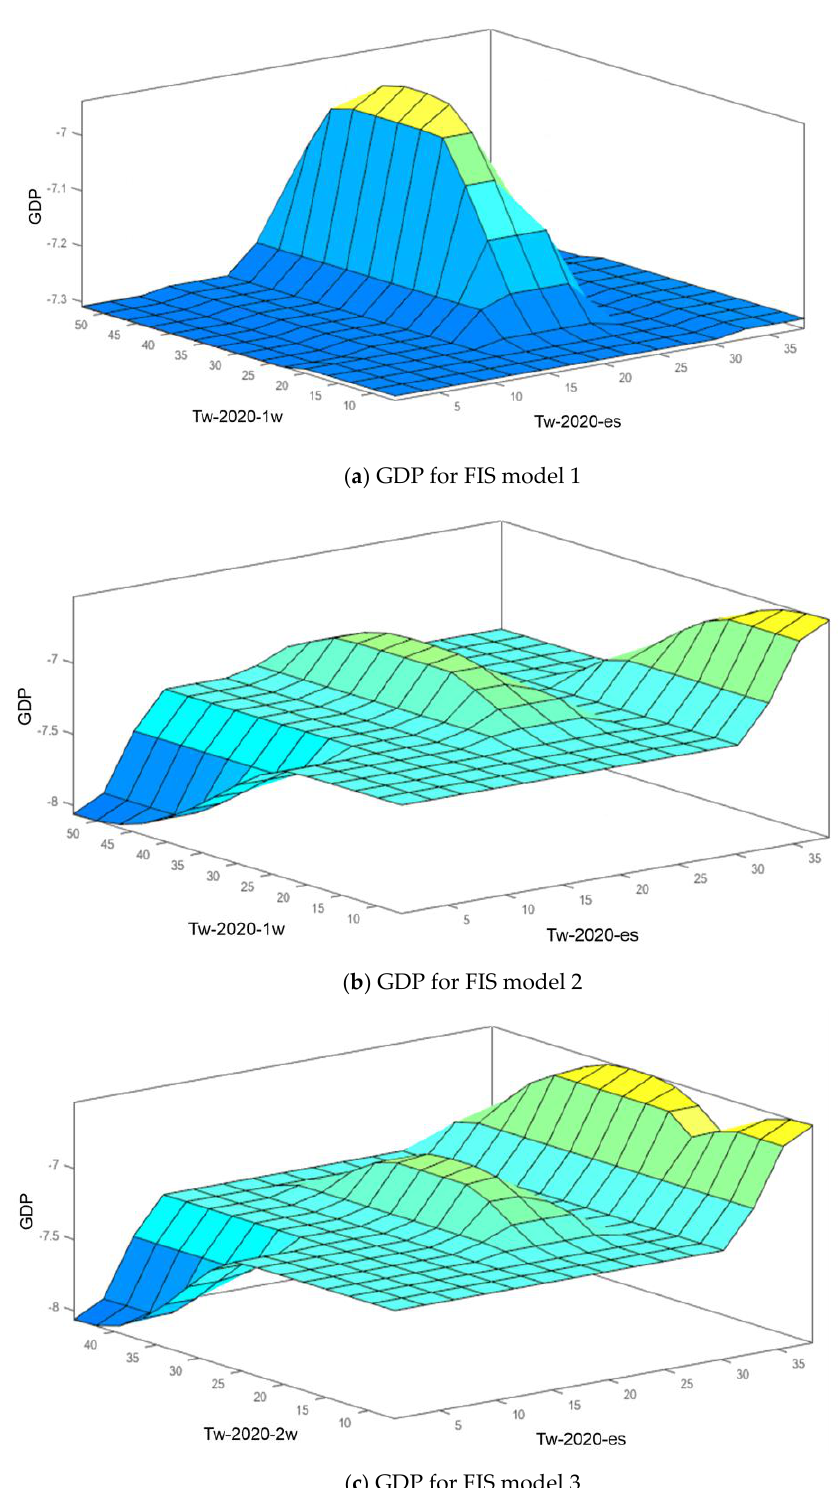
Figure 9. Diagrams associated with the distribution of GDP.